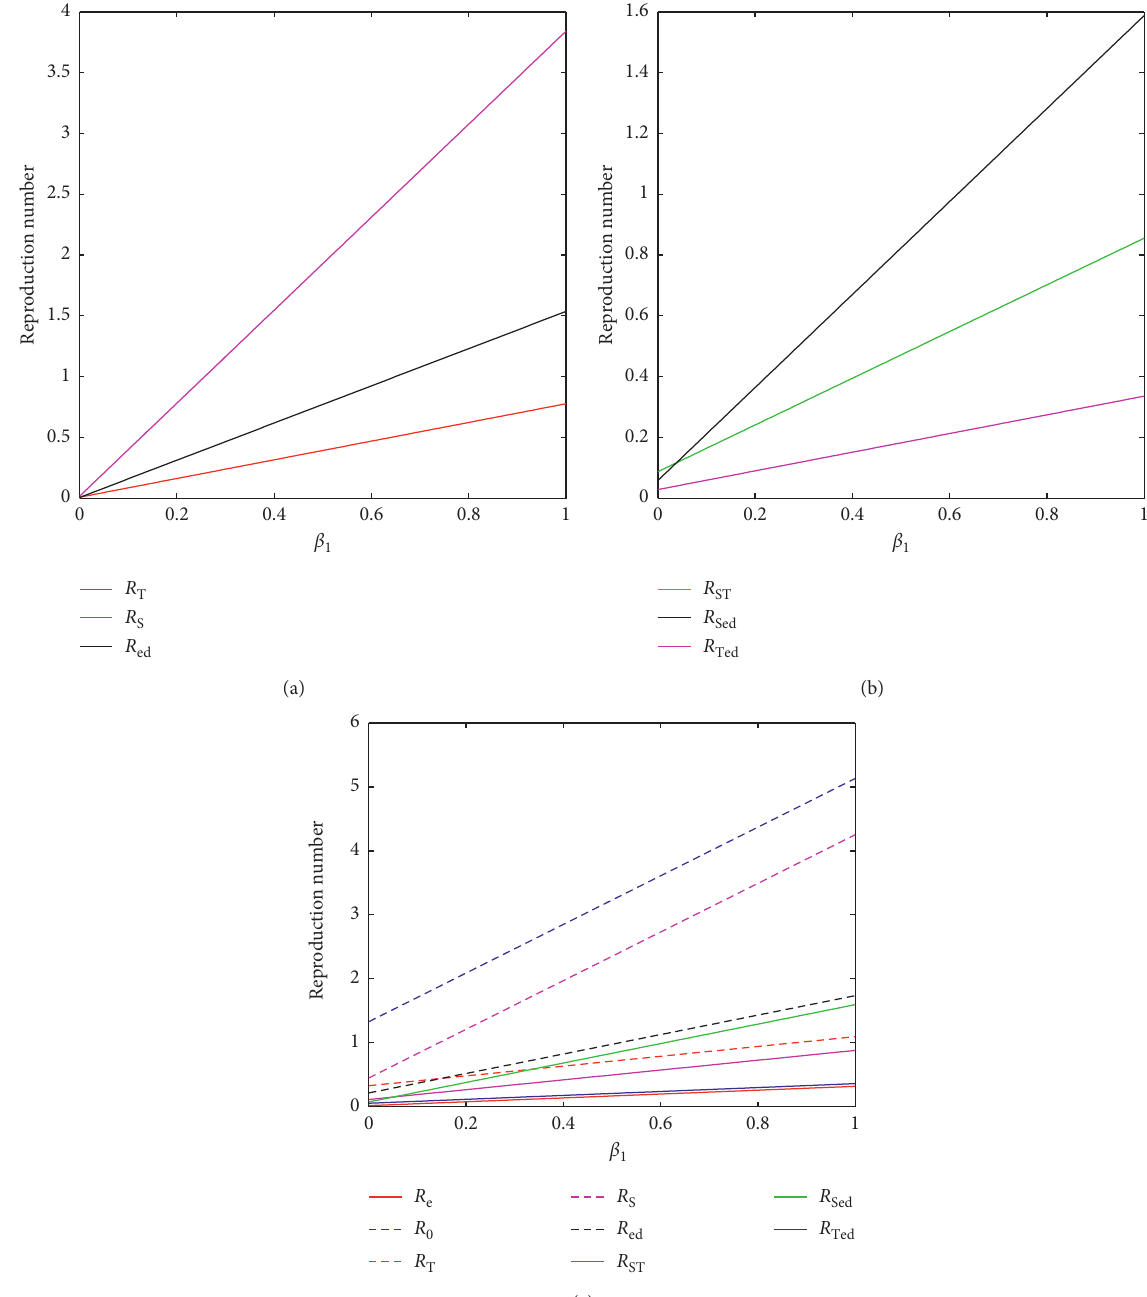
Figure 2: The comparison of single strategies (a), double strategies (b), and three control strategies (c). Basic reproduction number ( R the largest followed by single induced reproduction numbers and then the dual controls and the least being reproduction number capturing all three controls ( R e ). Note that reproduction number with education and treatment efforts ( R